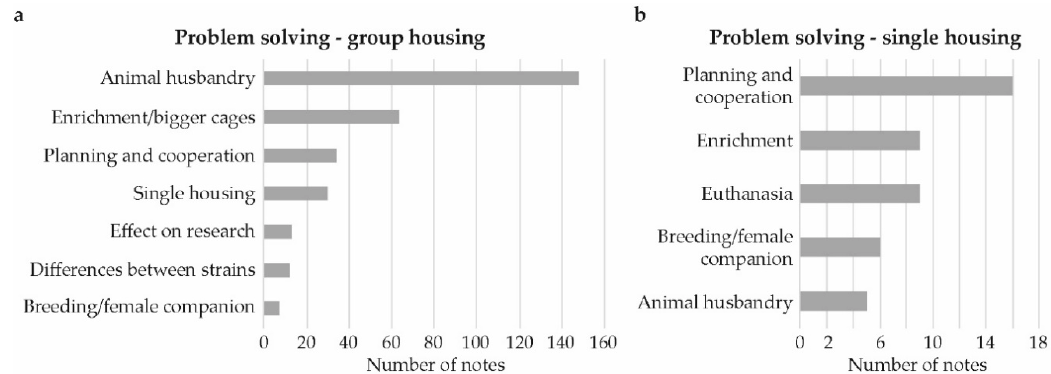
Figure 3. Problem solving for group- and single-housed male mice. Number of comments per category, describing experiences with problem solving or ideas for problem solving by laboratory animal veterinarians, researchers, and animal technicians when: ( a ) group or, ( b ) single housing male mice at research facilities in